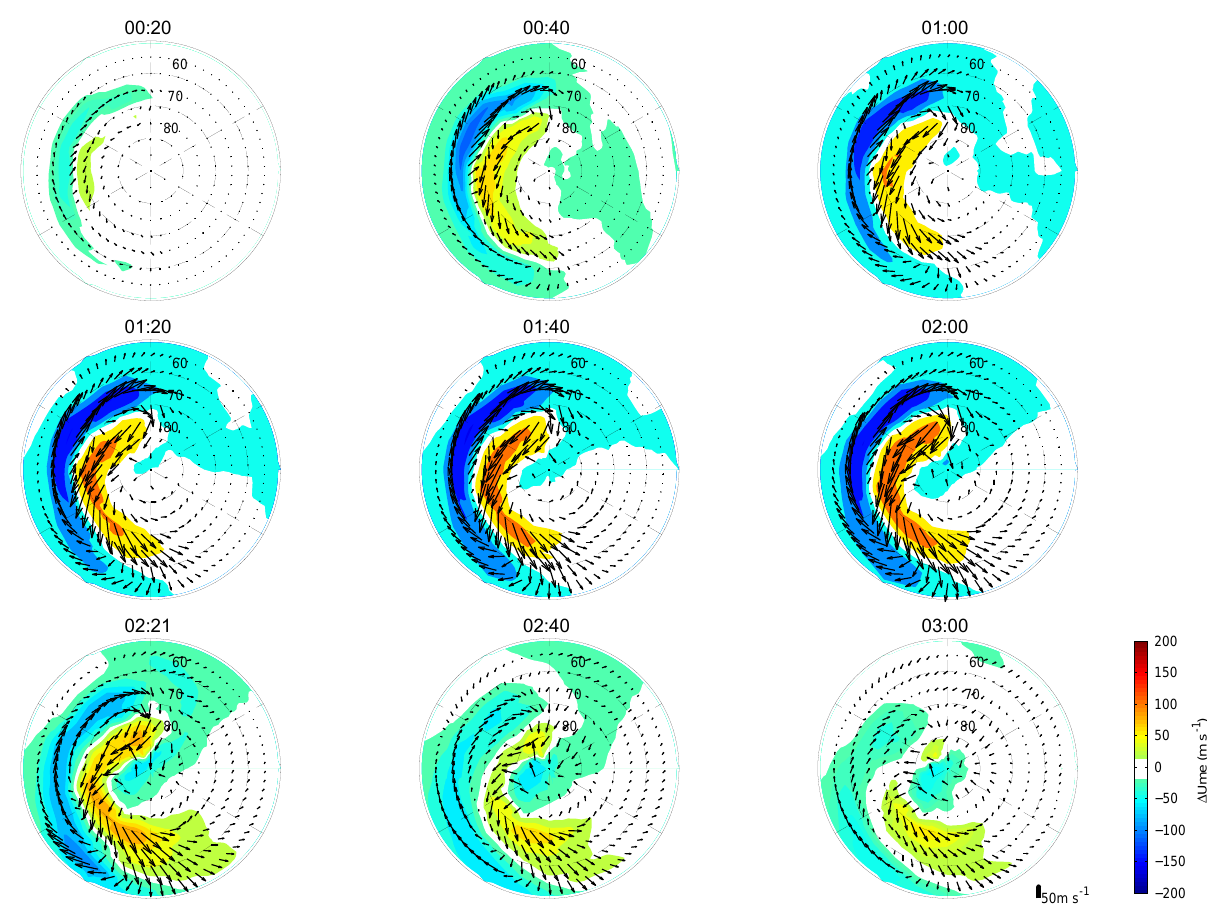
Figure 3. Geomagnetic latitude and magnetic local time variation of the disturbance neutral zonal wind in the Northern Hemisphere from 00:20 to 03:00epoch time. The wind velocity at the same UT but 24h earlier has been subtracted in each panel. Vectors are shown with black arrows, and the zonal velocity is shown in color. Negative values represent westward neutral wind